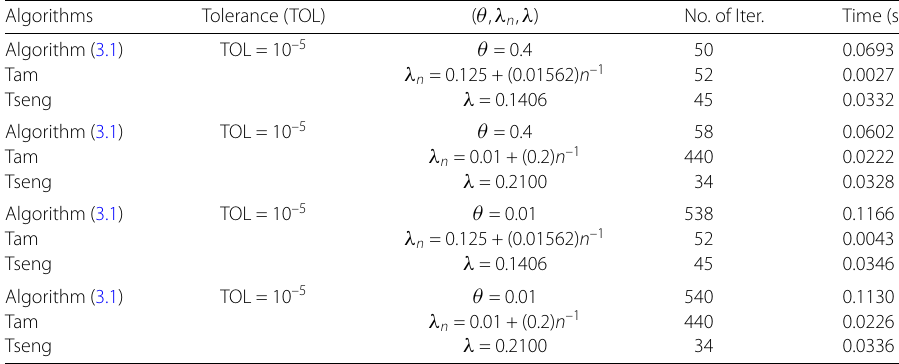
Table 2 Computational Results for Example 2